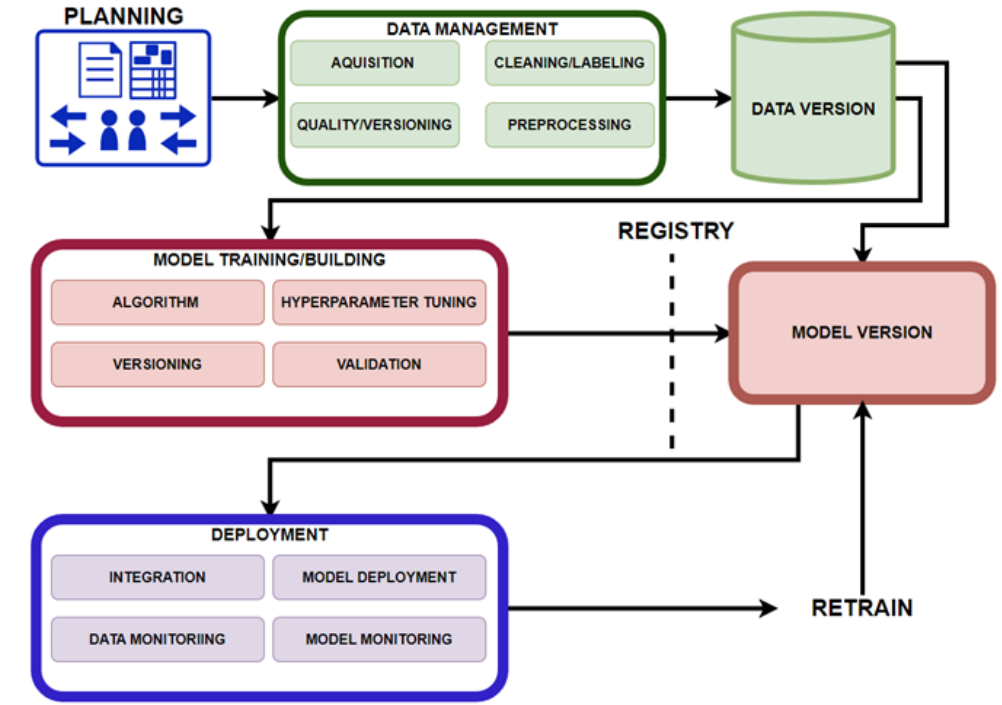
Figure 10. Machine Learning Operations